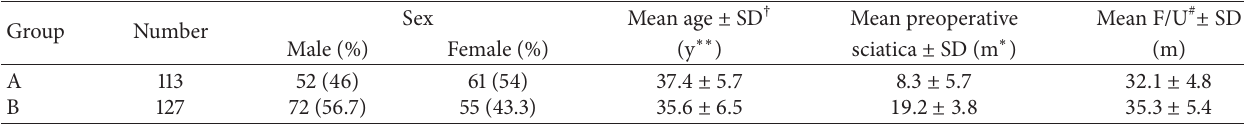
Table 1: Demographic data of our treated patients.